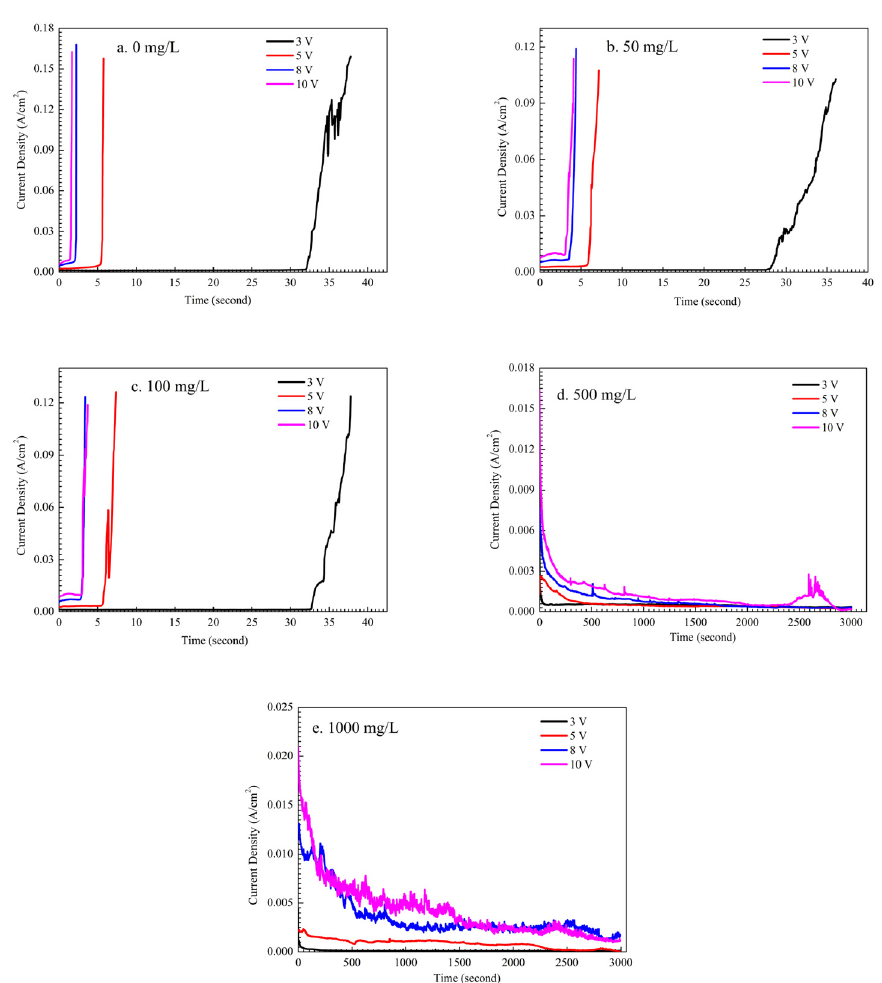
Figure 3. Current density vs. time curves for ECM tests of tin under a droplet of 15 μ L containing different concentrations of Na 2 HPO 4 under various bias conditions: ( a ) 0 mg/L; ( b ) 50 mg/L; ( c ) 100 mg/L; ( d ) 500 mg/L; ( e ) 1000 mg/L.